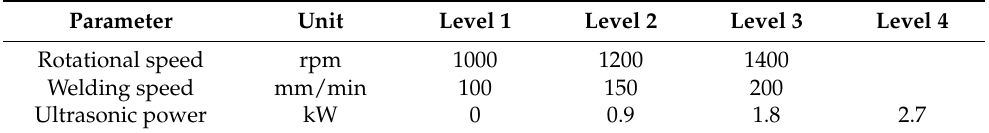
Table 3. Welding variables and their levels.